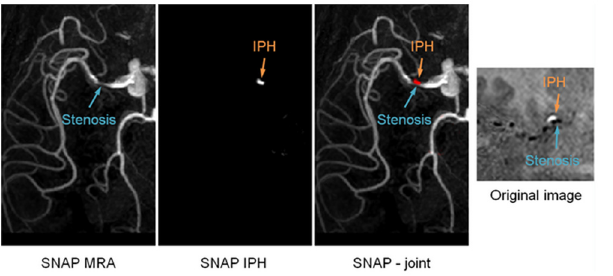
Fig 5. The simultaneous visualization of MRA and IPH/Thrombosis using the SNAP sequence. On the left are reformatted SNAP MRA, IPH/T and joint MIP view to facilitate image review. One the right is the original image at the cross-section of the MCA artery. Obvious contrast between IPH/Thrombosis (positive magnetization) and luminal (negative magnetization) signal can be